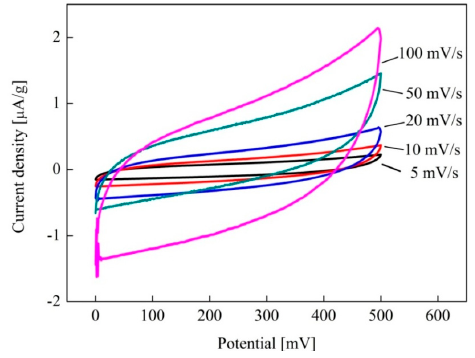
Figure 7. Cyclic voltammetry curves of the LATP sample measured with different scan rates.